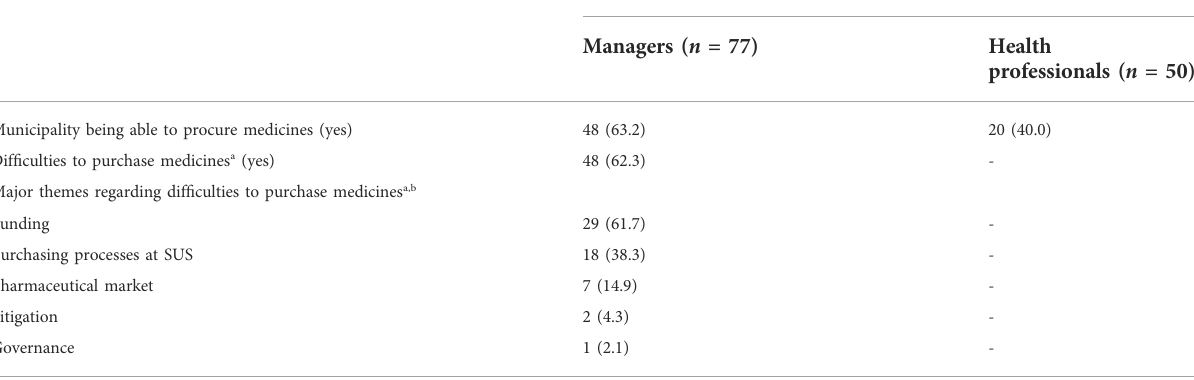
TABLE 4 Managers and health professionals ’ perceptions regarding medicines procurement. MedMinas Project, 2019.